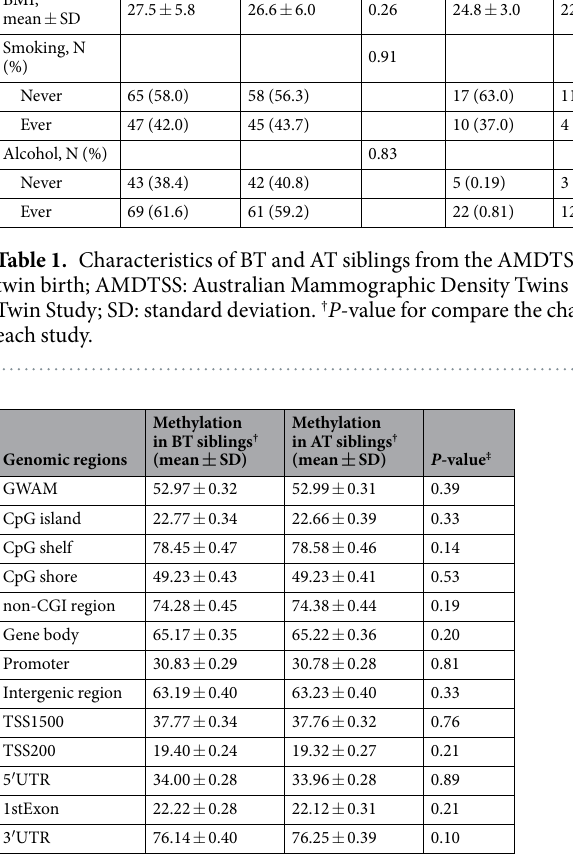
Table 2. GWAM and the average methylation of genomic regions between BT and AT siblings from the AMDTSS * * GWAM: genome-wide average methylation; BT: before twin birth; AT: after twin birth; AMDTSS: Australian Mammographic Density Twins and Sisters Study; SD: standard deviation. † Methylation is presented as the percentage of methylation, that is, beta-value × 100. ‡ P -value for compare the mean of methylation between BT and AT